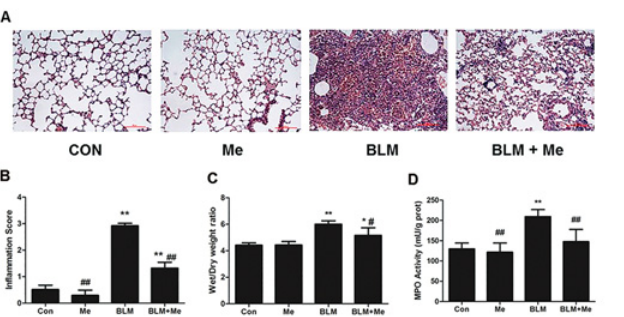
Fig 2. Memantine reduces bleomycin-induced alveolitis and neutrophil infiltration. The lung tissues were collected on Day 7. (A) The histopathologic examination was determined by H&E staining. (×200, Scale bar = 100 μ m). (B) The comparisons of the inflammation score values in each group. n = 4 – 7. (C) W/D ratio, n = 5 – 9. (D) The activity of MPO in lung homogenate, n = 3 – 6. Bars: mean ± SD. * P < 0.05, ** P < 0.01